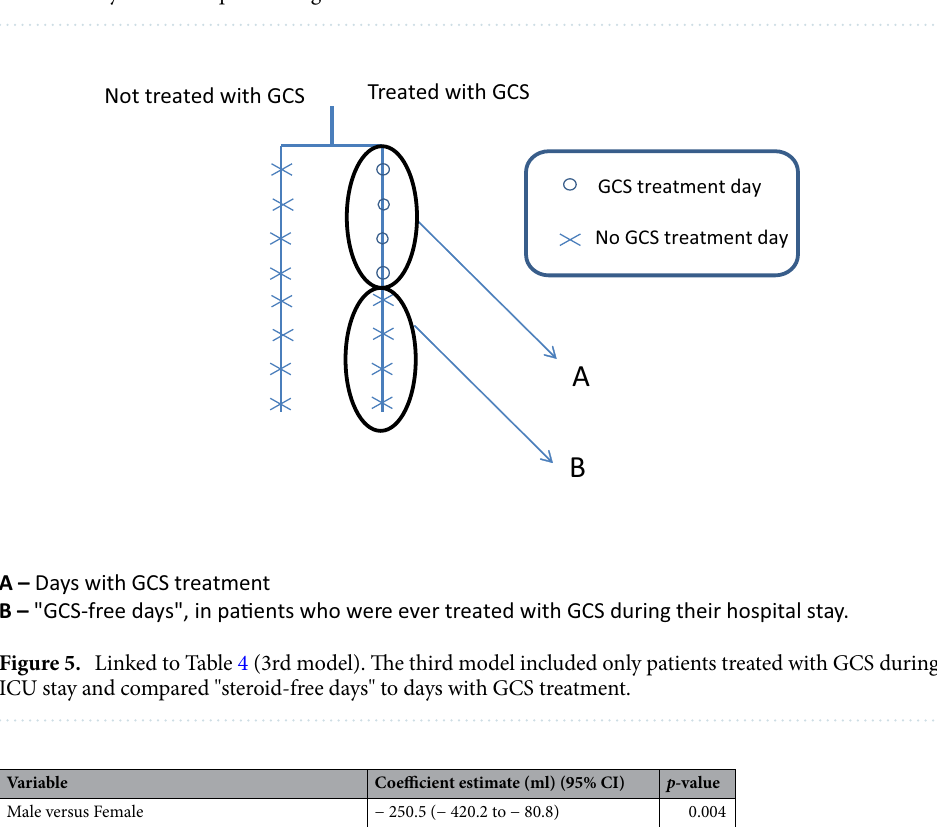
Table 4. Model 3 of the estimated effect of glucocorticoids (GCS) treatment per day on daily fluid balance (ml) in patients with sepsis who were treated with GCS during their stay in the intensive care unit (ICU). This model included only patients treated with GCS during their ICU stay and compared between GCS days and GCS-free days. SOFA sequential organ failure assessment.